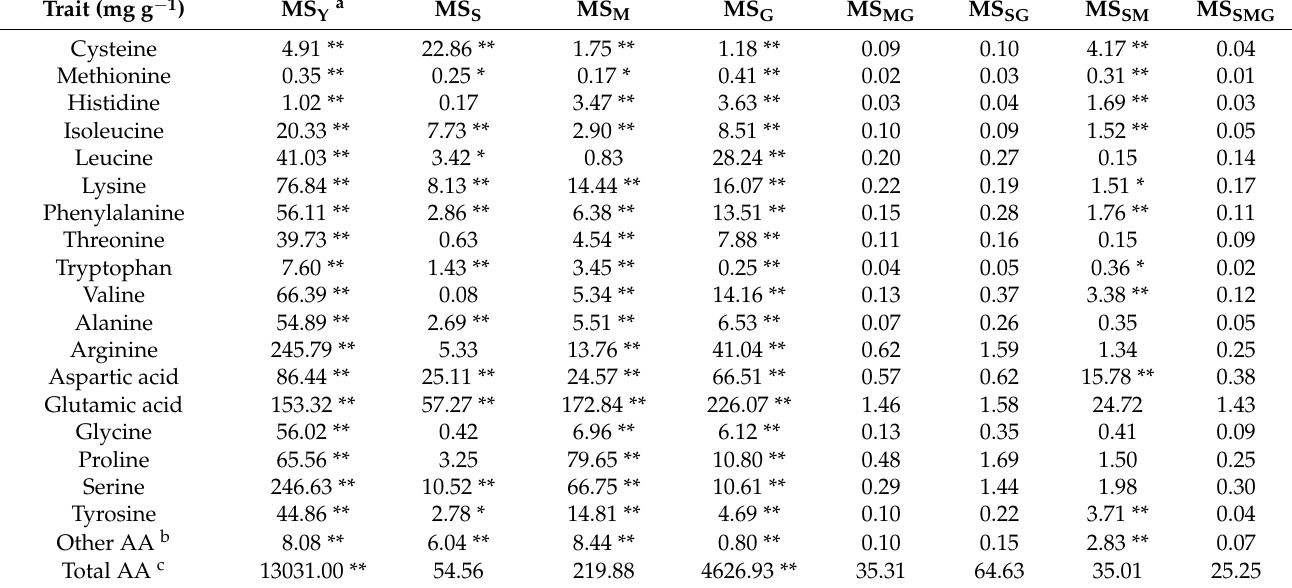
* and **, Significant at p = 0.05 and 0.01, respectively, based on F tests. a MS Y , MS S , MS M , MS G , MS MG , MS SG , MS SM , and MS SMG represent the mean squares of year, sample type, drying method, genotype, and method × genotype, sample × genotype, sample × method and sample × method × genotype interaction effects, respectively. b Sum of hydroxylysine, hydroxyproline, lanthionine, ornithine and taurine. c Sum of all amino acids